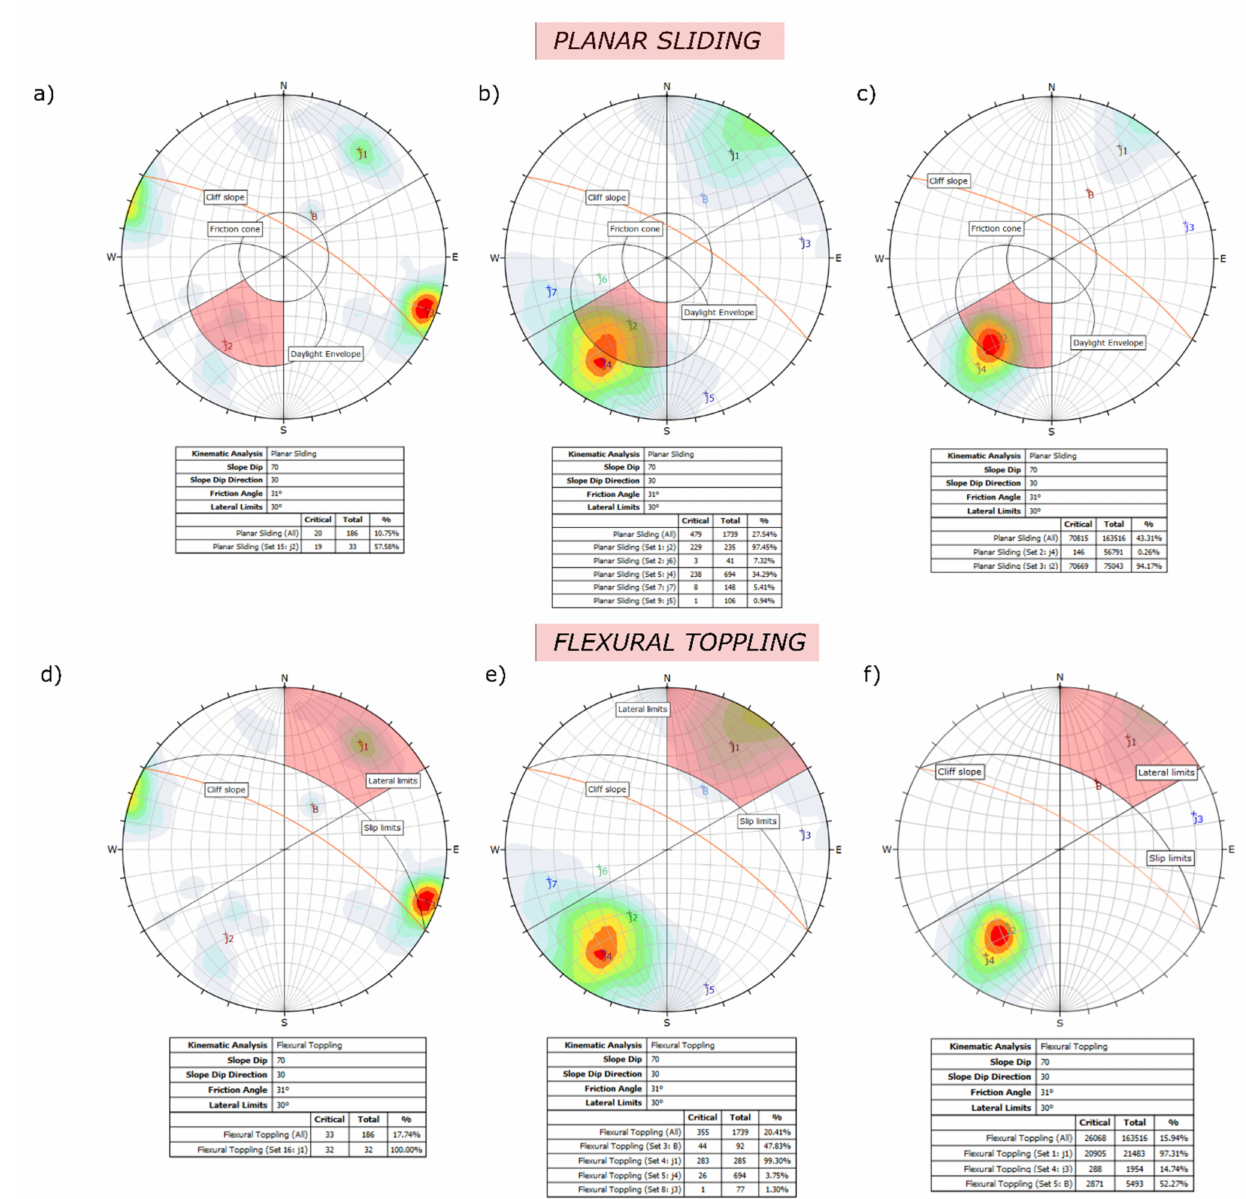
Figure 12. Kinematic analysis of rock slope failure. ( a ) planar sliding from traditional geological survey; ( b ) planar sliding from the DCS approach; ( c ) planar sliding from FACETS algorithm; ( d ) flexural toppling from traditional geological survey; ( e ) flexural toppling from DCS approach; ( f ) flexural toppling from FACETS